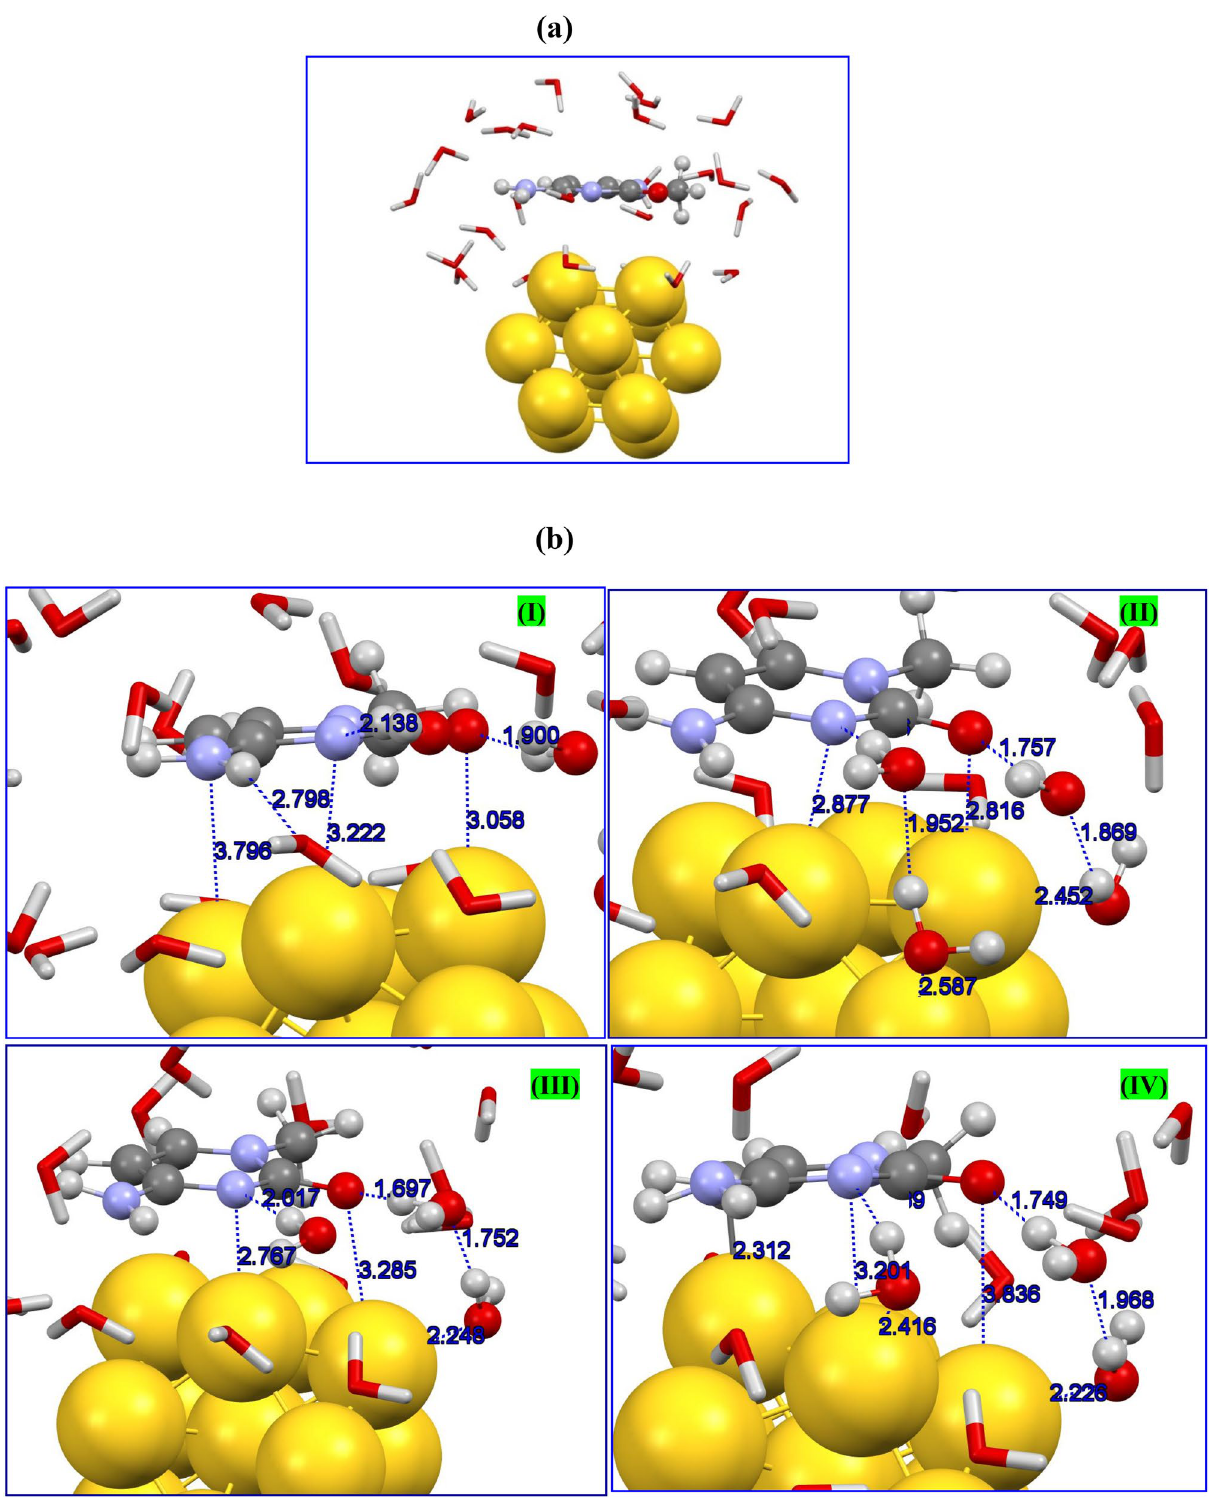
Figure 4. Schematic representation of ( a ) initial configuration and ( b ) snapshots of configurations during the optimization procedure for cytosine - Au13/25H 2 O system with DFT ‒